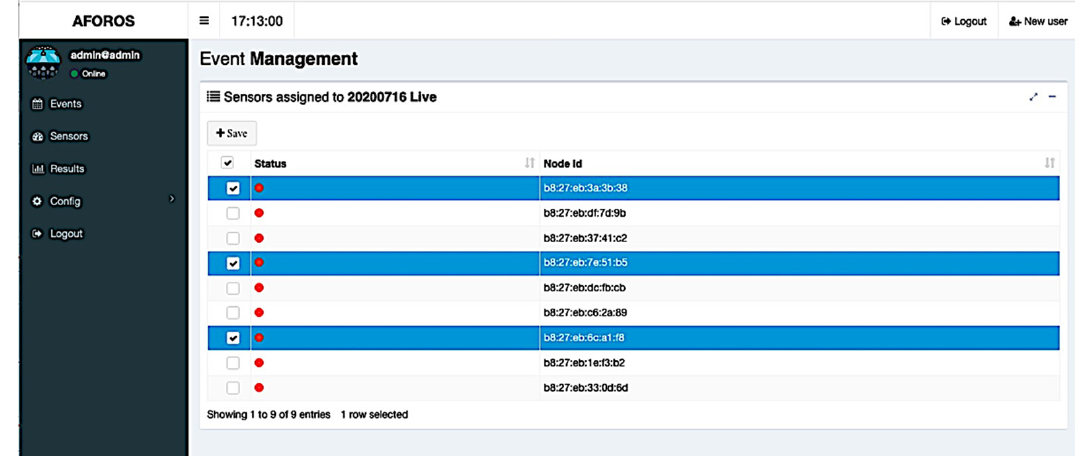
Figure 9. Sensor assignment in the web application.